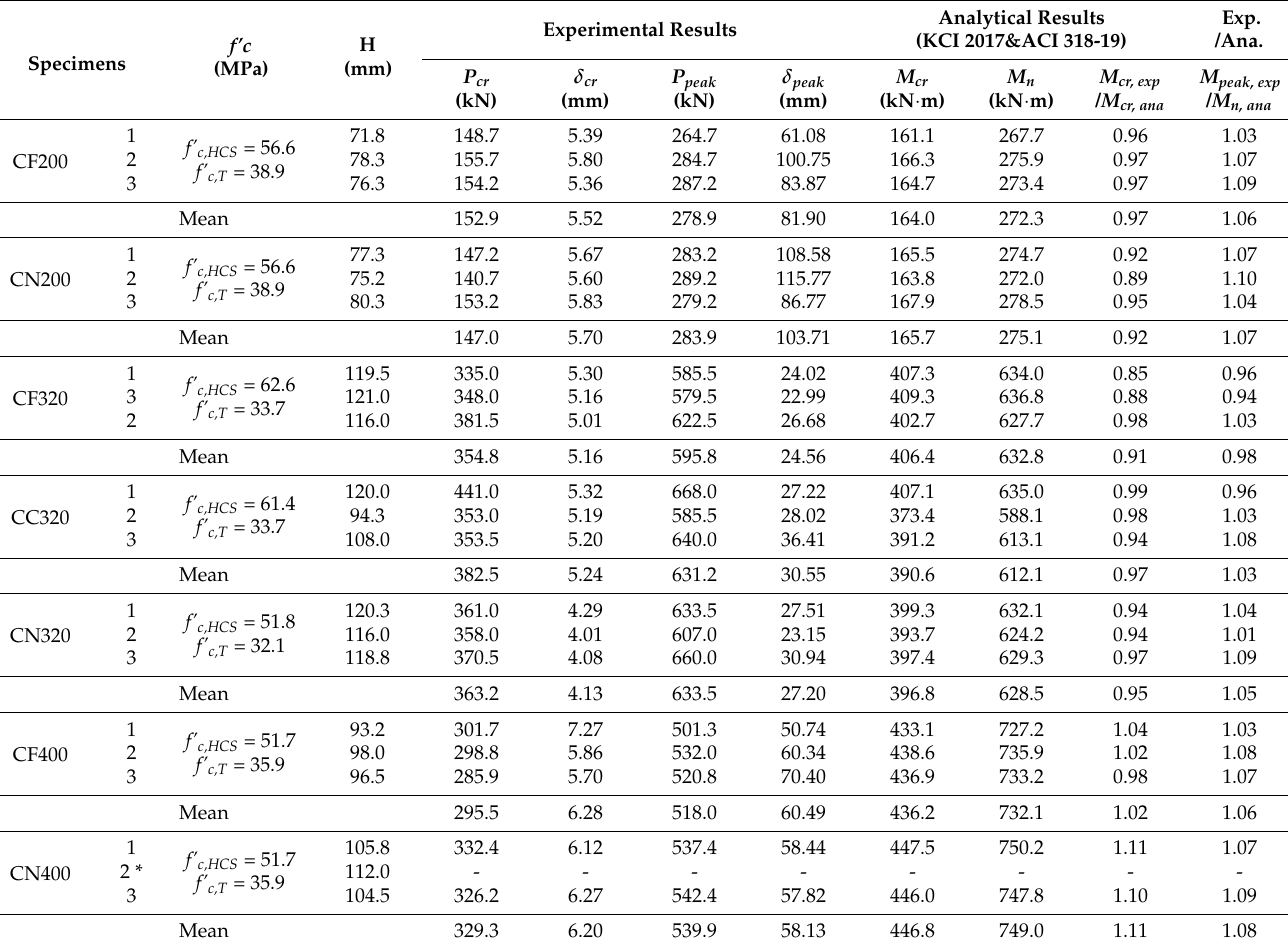
Table 3. Comparison between analytical and experimental